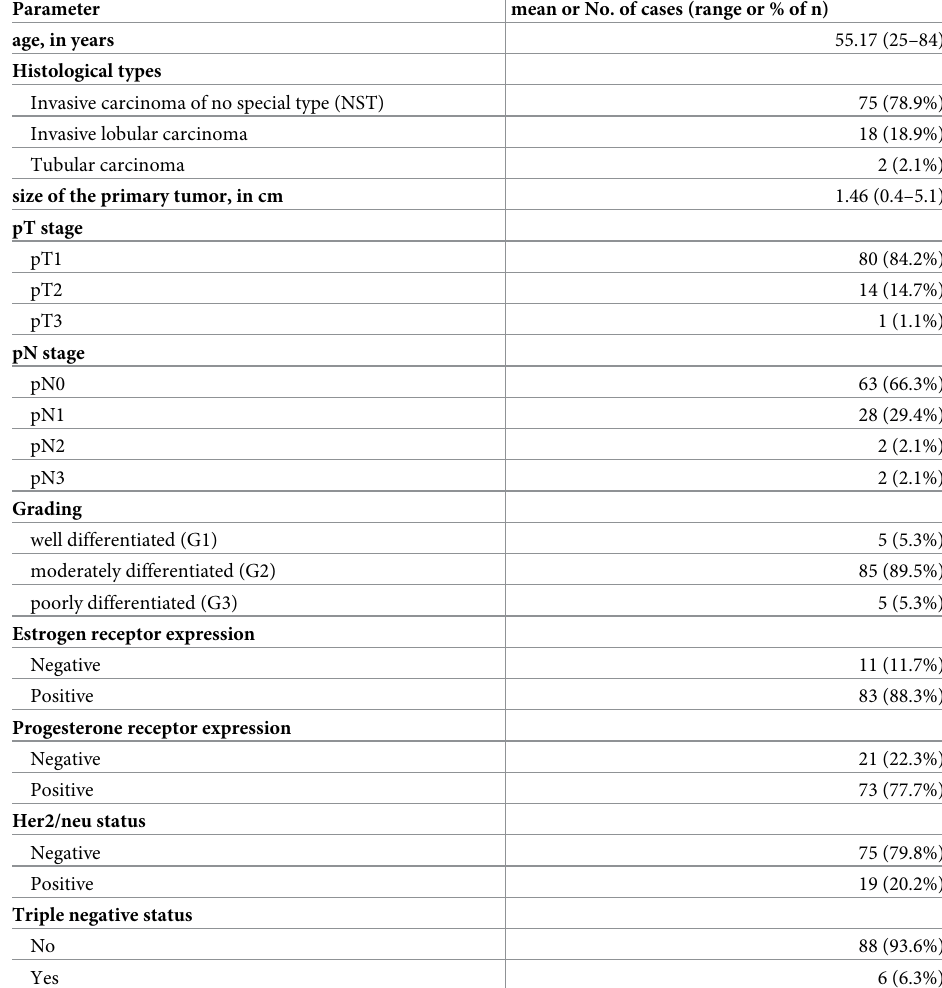
Table 1. Clinicopathological characteristics of the patients involved in this study (n =